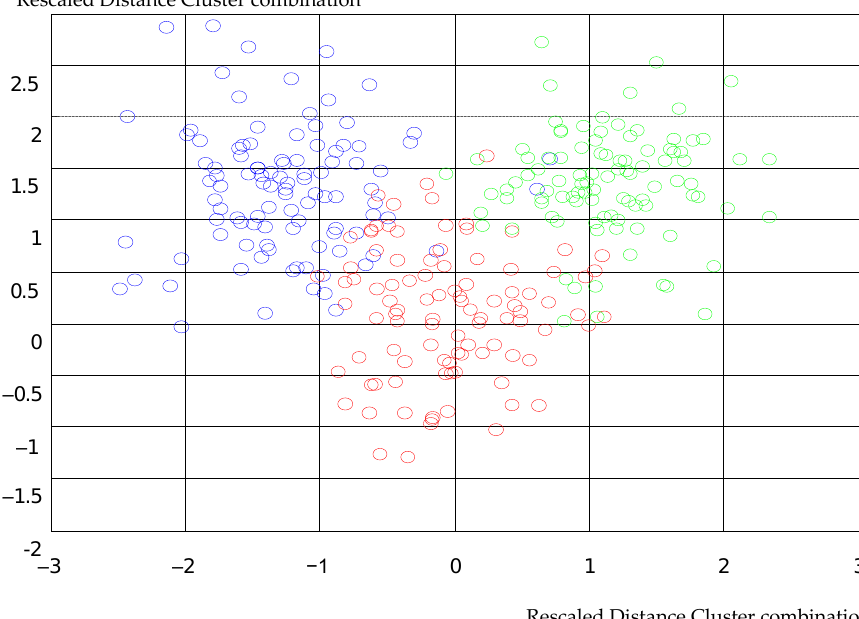
Figure 5. Improved KNN (k-Nearest Neighbor) clustering data of vehicle speed.